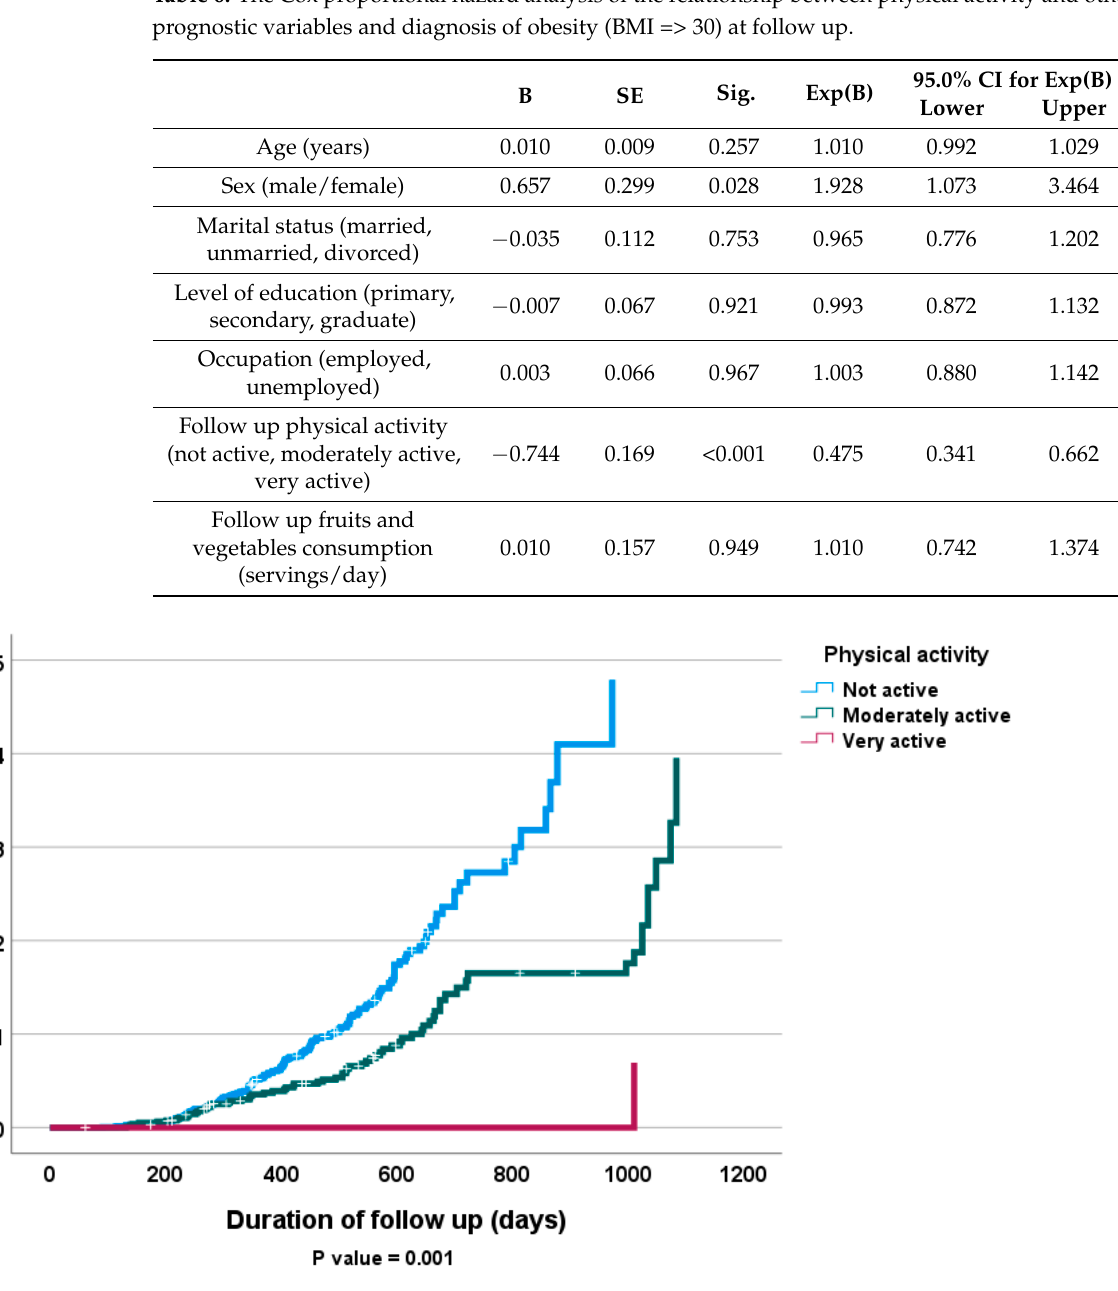
Figure 1. Kaplan–Meier of cumulative odds of WC => 80 cm in female subjects according to levels of physical activity at follow up.